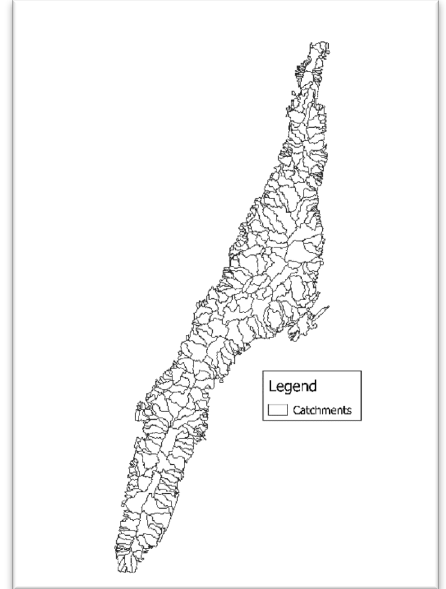
Figure 2. Catchments mapped from watershed